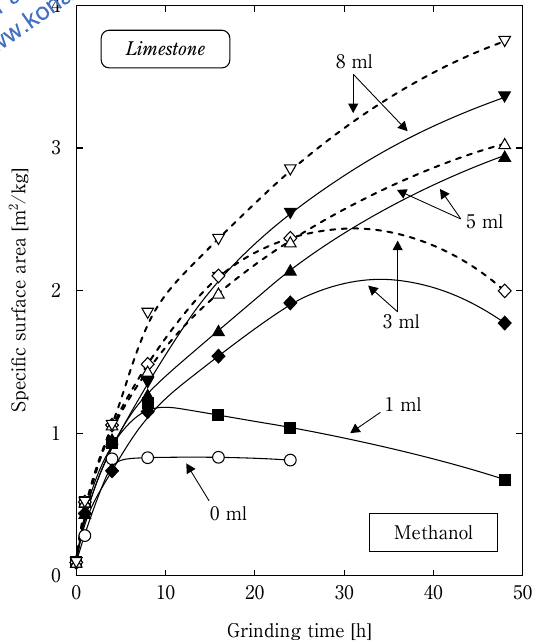
Fig. 6 Effect of the addition method of methanol on specific surface area of limestone.